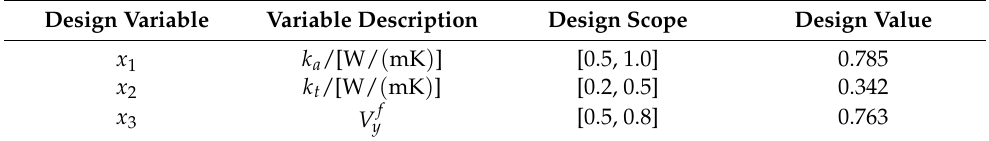
Table 2. Optimized design parameters of Carbonized Silica/Phenolic woven